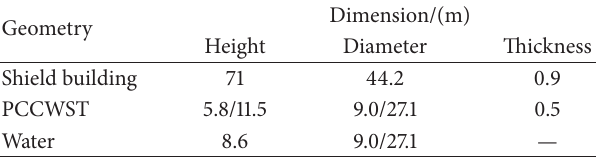
Table 1: The geometry of shield building.